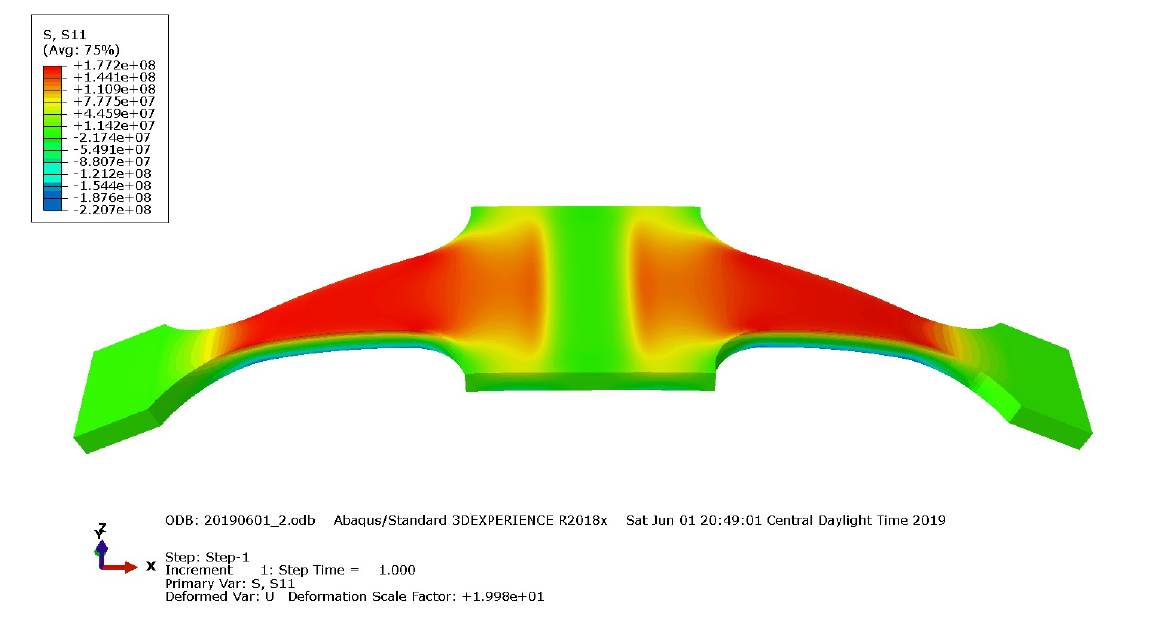
Figure 3. FEA simulation result of the specimen. The red zone on the top surface shows the stress distribution is constant within the gauges.